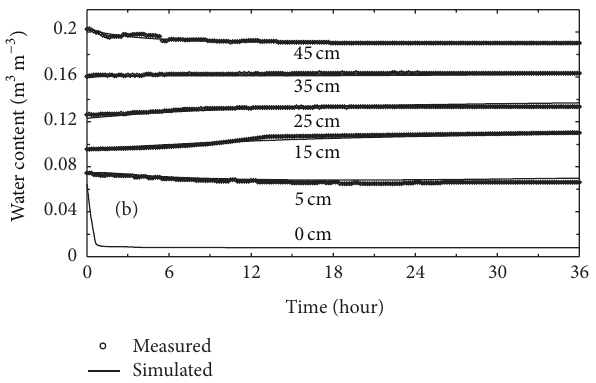
Figure 3: Temporal changes in simulated and measured soil water contents at different